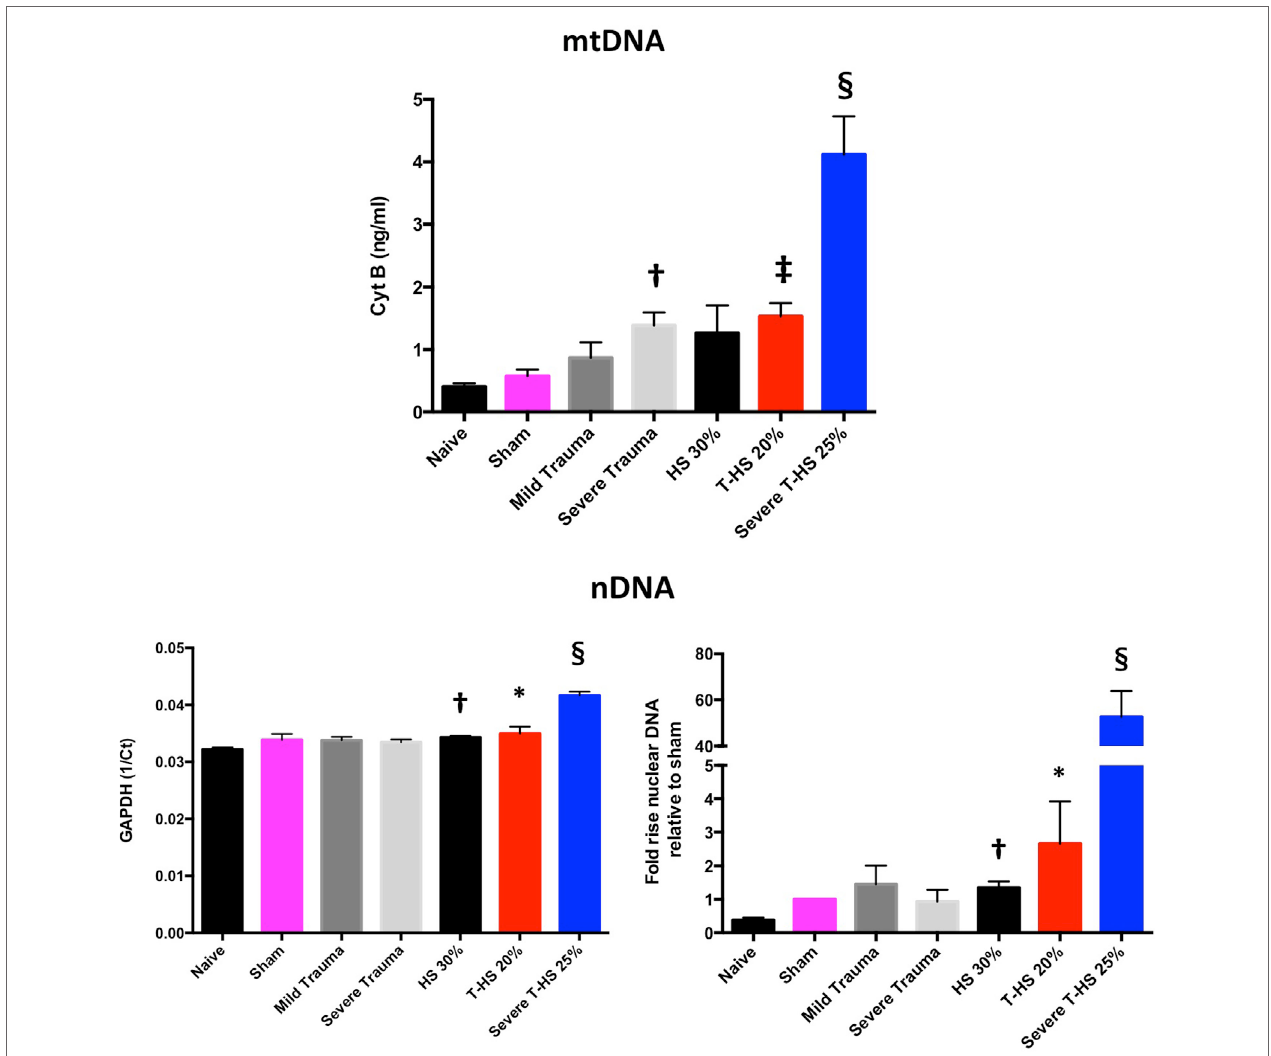
FigUre 3 | Plasma mitochondrial DNA (mtDNA) and nDNA concentrations taken at 6 h from rodents subjected to increasing degrees of traumatic injury and shock. Top panel, fully quantified mtDNA concentrations from real-time polymerase chain reaction (Cyt B). Bottom panels, nDNA, 1/Ct (GAPDH) and fold increases relative to sham concentrations displayed. There was a dose-dependent increase in mtDNA with increasing trauma severity as opposed to pure HS; † denotes p < 0.01 for severe trauma vs naïve animals. With increasing severity of concomitant shock there again was a dose-dependent increase in mtDNA, ‡ denotes p < 0.001 and § denotes p < 0.0001 for T-HS 20%, and severe T-HS 25%, respectively, vs naïve animals. There was moderate correlation between changes in mtDNA and nDNA concentration overall ( p < 0.01) but important differences emerged. There was no rise in nDNA with increasing traumatic injury but pure HS 30% induced a small but significant rise in nDNA, † denotes p < 0.01 vs naive animals. Severe T-HS resulted in a large rise in nDNA, § denotes p < 0.0001 vs naïve animals. t -tests used. Mean values with SEM bars